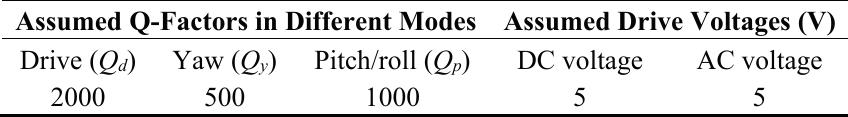
Table 10. Some assumed parameters for the